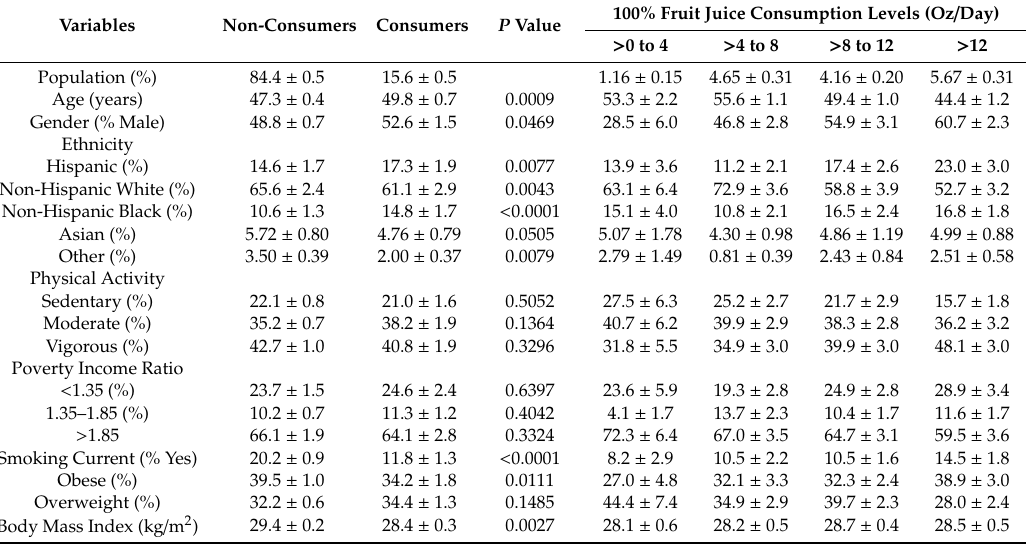
Table 2. Demographics associated with 100% fruit juice consumption in adults (19 + years of age)—NHANES 2013–2016